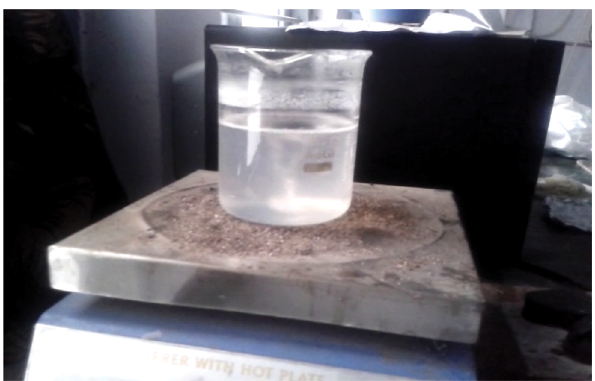
Figure 4: Starch solution after